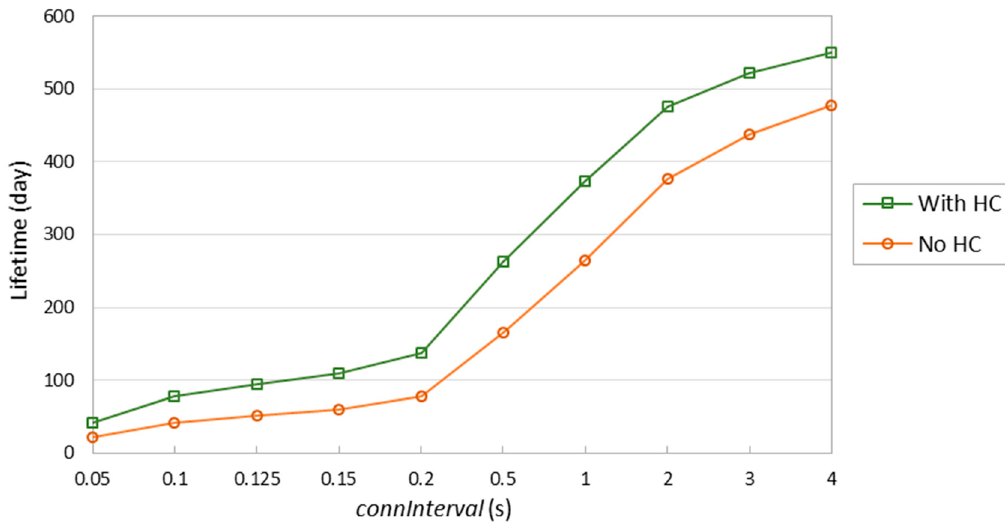
Figure 19. Device lifetime of a battery-operated PCA10028 6LN, for a 58-byte IPv6 data packet, with and without header compression (HC).